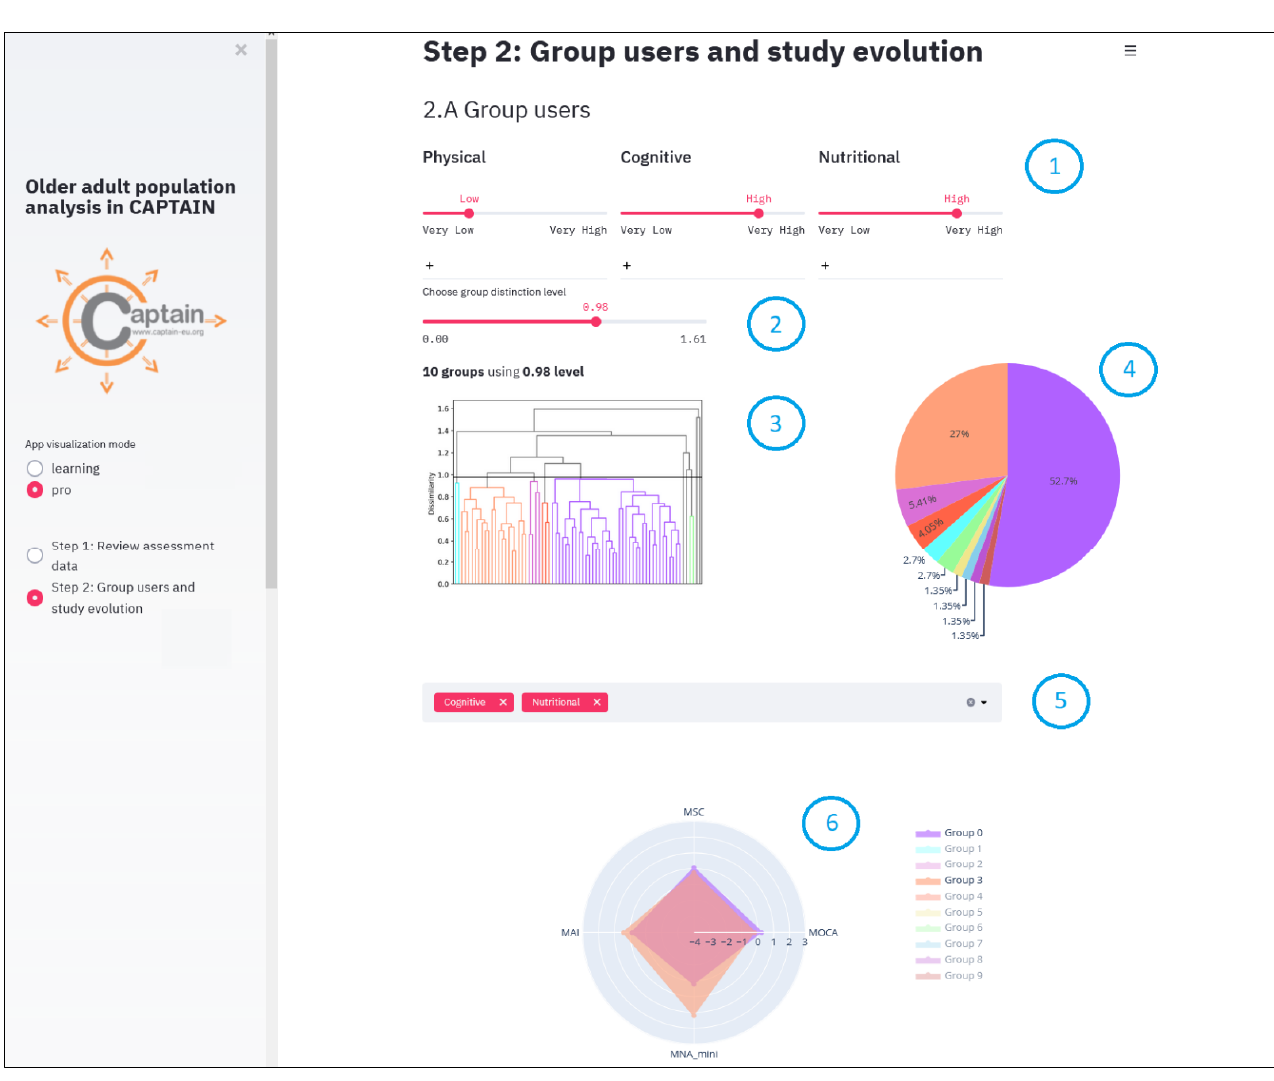
Figure 8. A use-case in Pro mode and Step 2, part Group users.